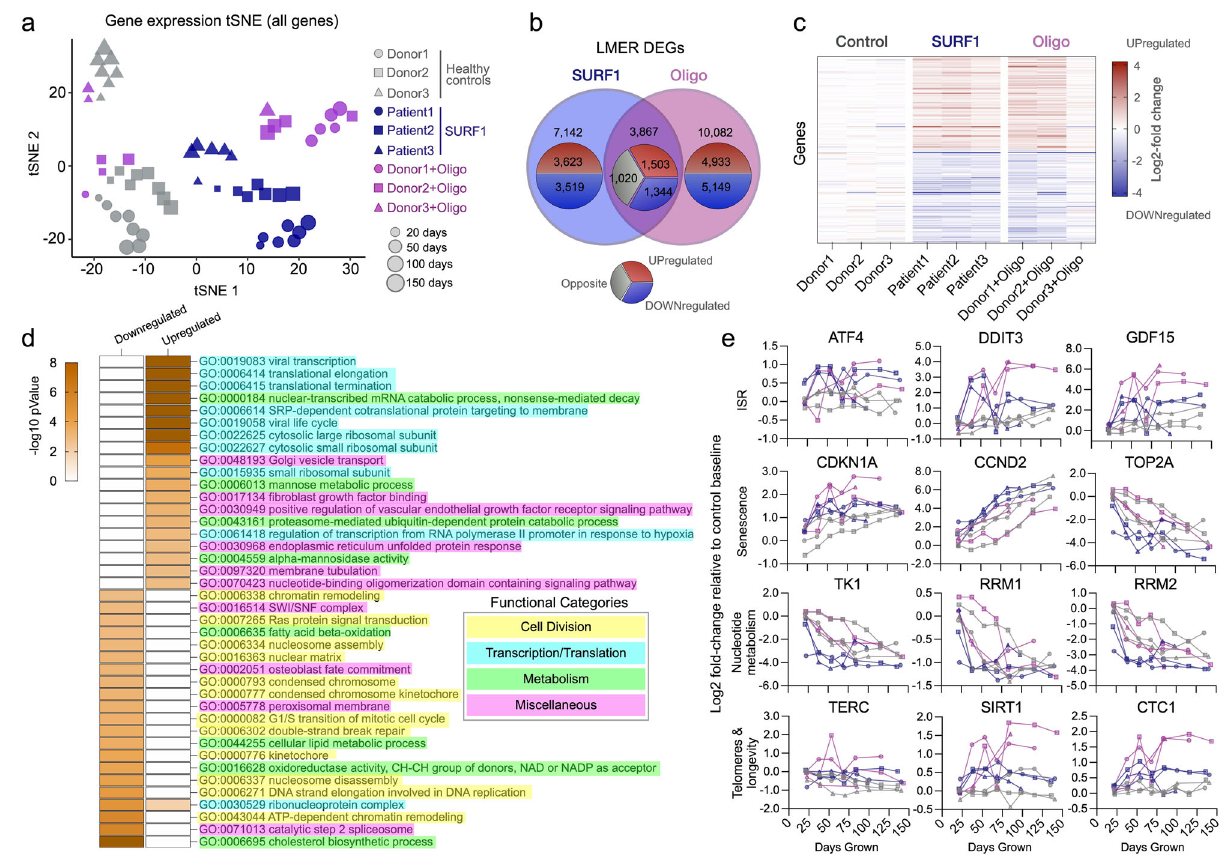
Fig. 6 Mitochondrial defects trigger conserved transcriptional remodeling. a t-distributed stochastic neighbor embedding (t-SNE) of RNAseq data from control, SURF1, and Oligo-treated human fi broblasts across the lifespan. b Overlap of signi fi cantly upregulated (red) or downregulated (blue) genes in SURF1and Oligo groups relative to control (linear mixed effects model, FDR-corrected p value<0.05). Note, outer group counts include shared counts in the overlapping rings. Gray indicates the diverging direction of regulation between SURF1 and Oligo DEGs. c Expression levels of the top 100 differentially expressed genes in SURF1 (<75 days grown) and Oligo-treated cells (days 35 – 110). d iPAGE analysis of RNAseq data showing the top 40 enriched gene ontology pathways in top overlapping upregulated and downregulated genes, conserved across both SURF1 and Oligo groups relative to control. Note, − log( p value)>8 are mapped as dark orange. e Gene expression timecourses of select genes related to the ISR, senescence, nucleotide metabolism, and telomere maintenance. Log2 expression values (TPM) are normalized to the median of the control youngest timepoints. n = 3 donors per group, 3 – 8 timepoints per